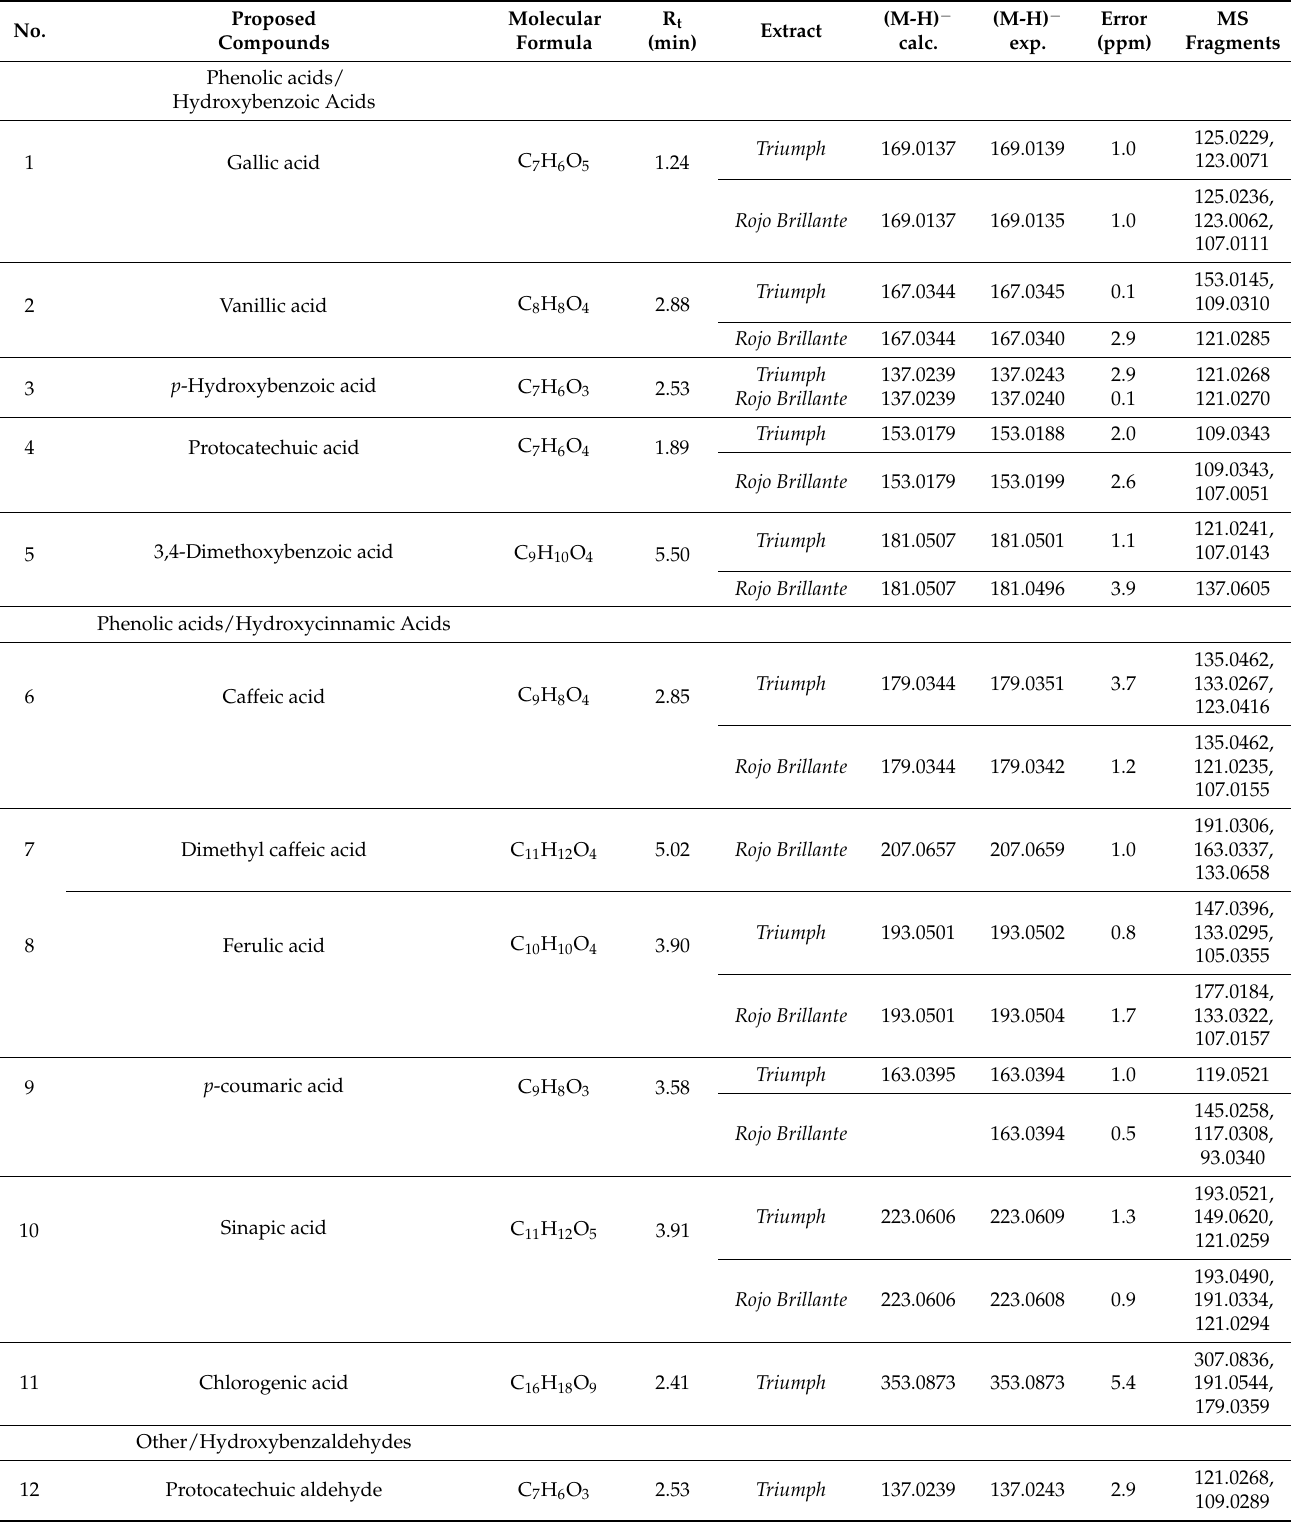
Table 1. Individual phenolic compounds identified in Rojo Brillante and Triumph